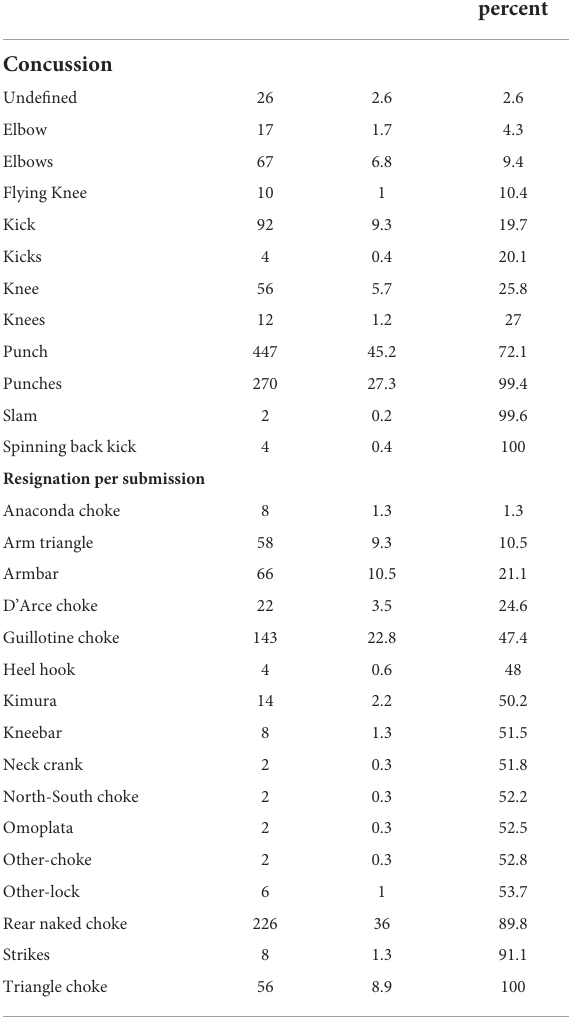
TABLE 4 Ending technique in frequency, percent and cumulative percent, according to concussion or resignation per submission